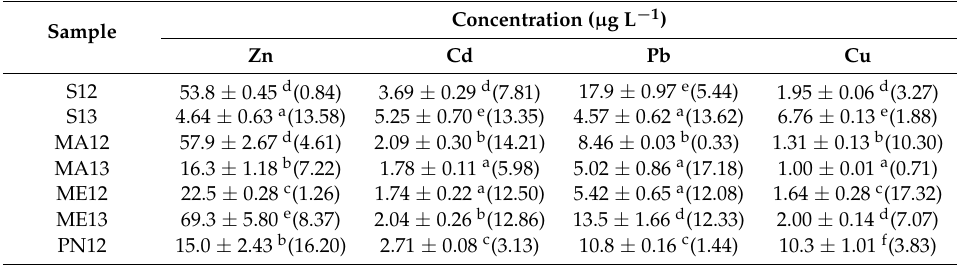
Table 1. Mean concentrations ( µ g L − 1 ) of Zn, Cd, Pb and Cu in